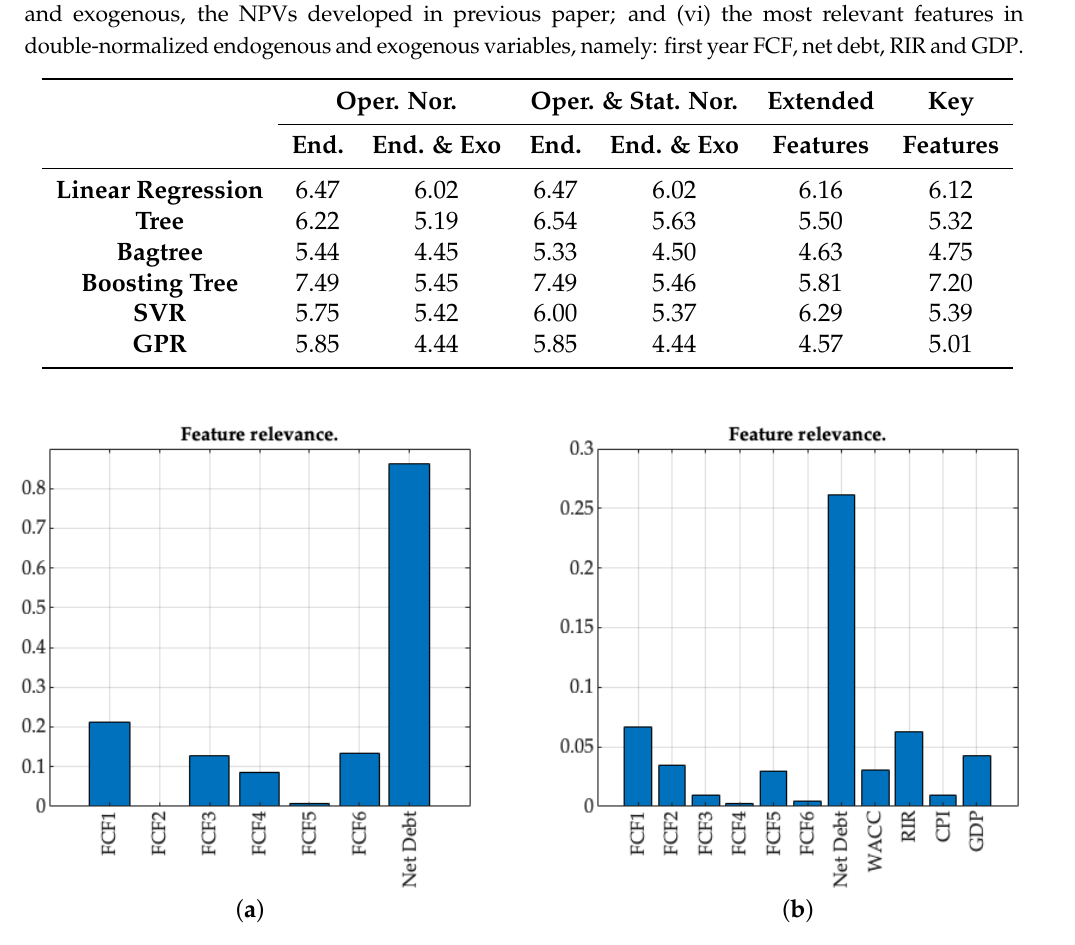
Table 4. Result comparison based on RMSE for better performing ML implemented techniques.